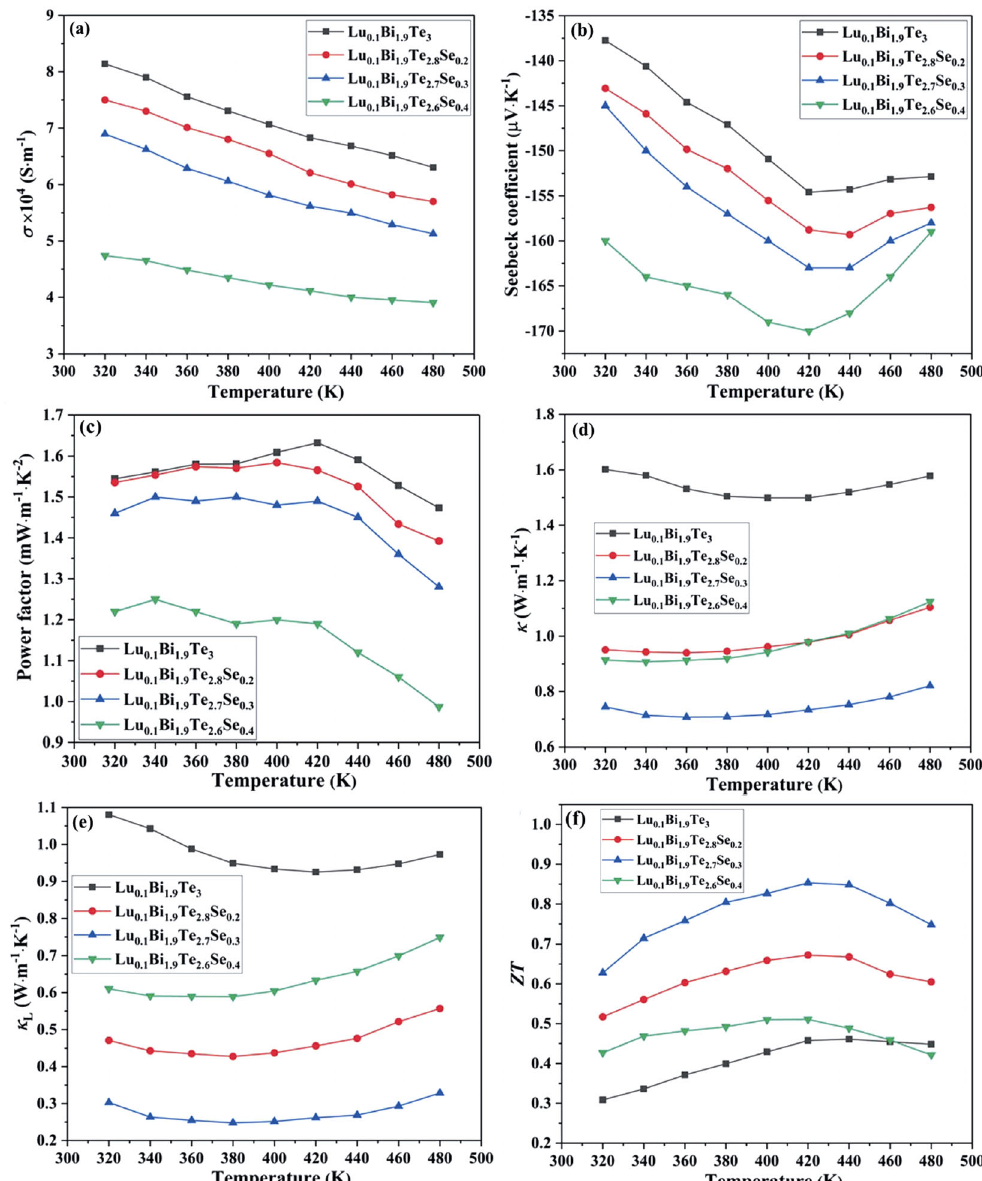
Fig. 4 Temperature-dependent thermoelectric properties of all bulk samples: (a) electrical conductivity; (b) Seebeck coefficient; (c) power factor; (d) total thermal conductivity; (e) lattice thermal conductivity; (f) ZT